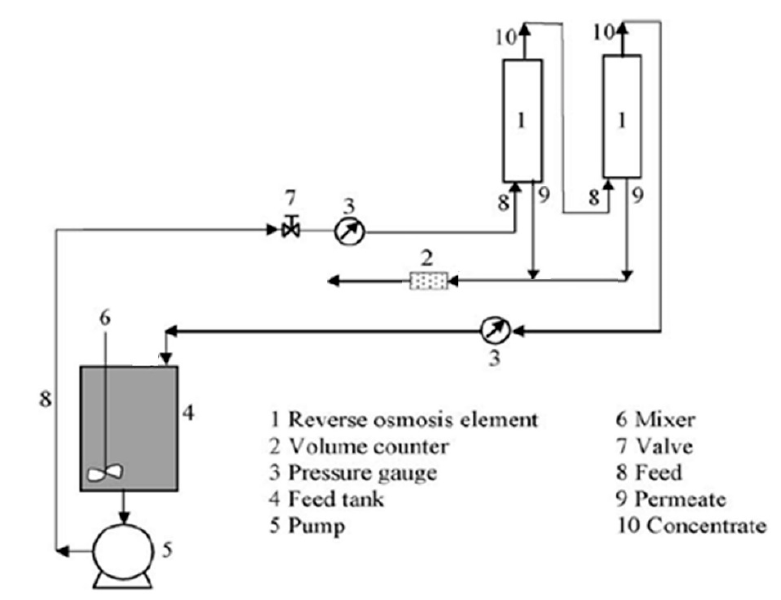
Figure 1. Schematic RO process.